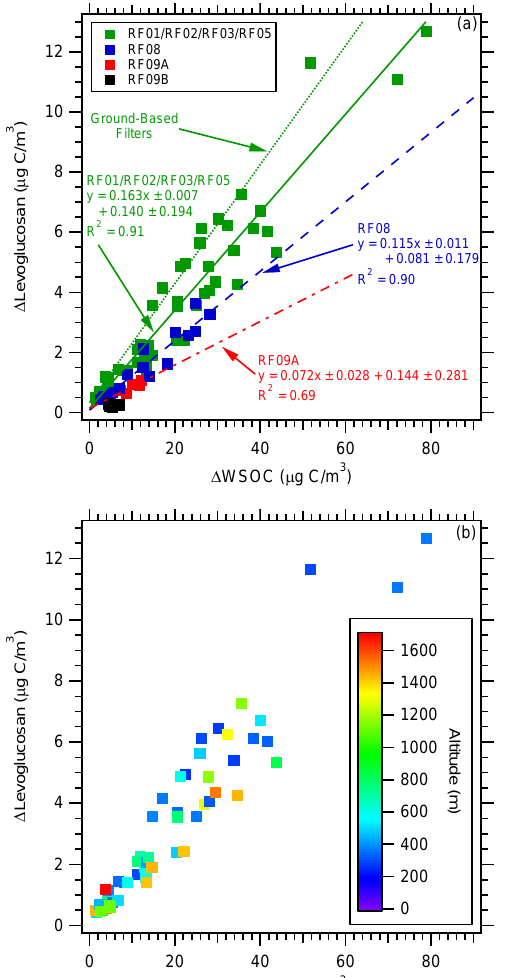
Figure 4. Correlation of (a) 1 levoglucosan vs. 1 WSOC on a car- bon mass basis for all flights with the data segregated by fire loca- tion and (b) 1 levoglucosan vs. 1 WSOC on a carbon mass basis for only the Fort Jackson prescribed burns colored by altitude. In plot (a) , the fit through the filter samples collected on the ground during the burns conducted at Fort Jackson is also provided. Uncertainties with the least-square regressions are one standard deviation.